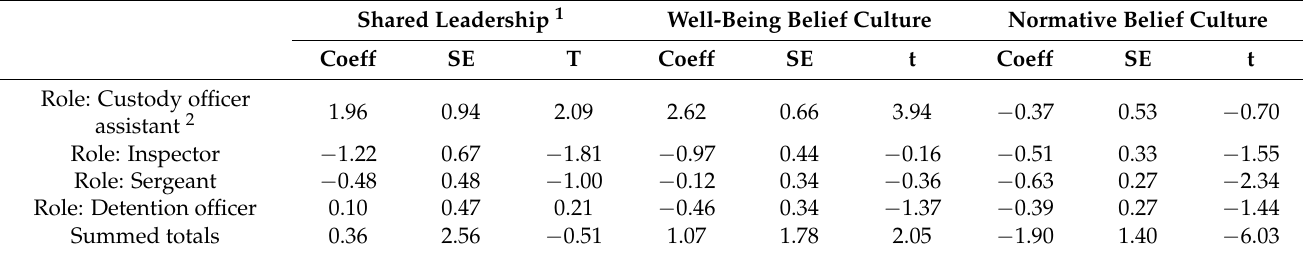
Table 4. Cultural sub-component